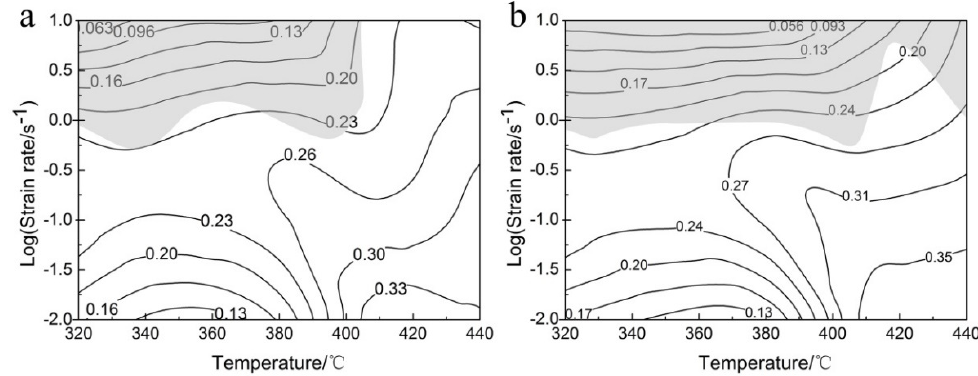
Figure 8. Processing maps of Al-Zn-Mg-Cu alloy at strains of ( a ) 0.3 and ( b ) 0.6.